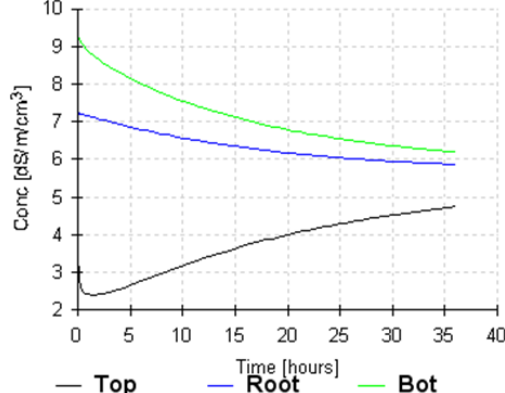
Figure 15. Changes in salt concentration calculated in the model at the upper model boundary (TOP), at the root zone bottom (about 35cm from the ground surface) (ROOT), and the lower model boundary